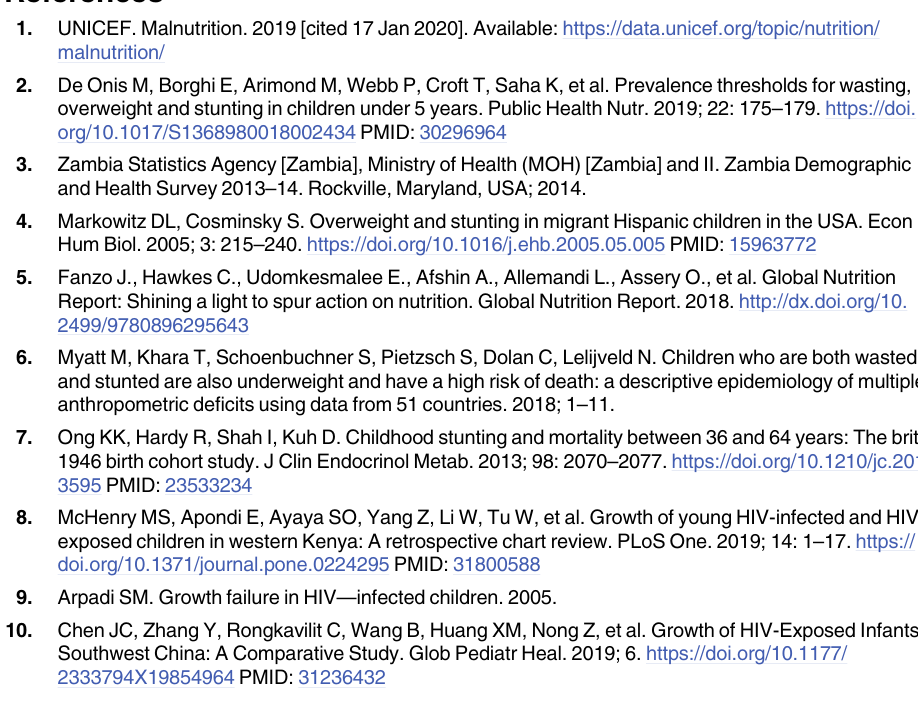
S2 Fig. Correlation between residuals and the fitted values.